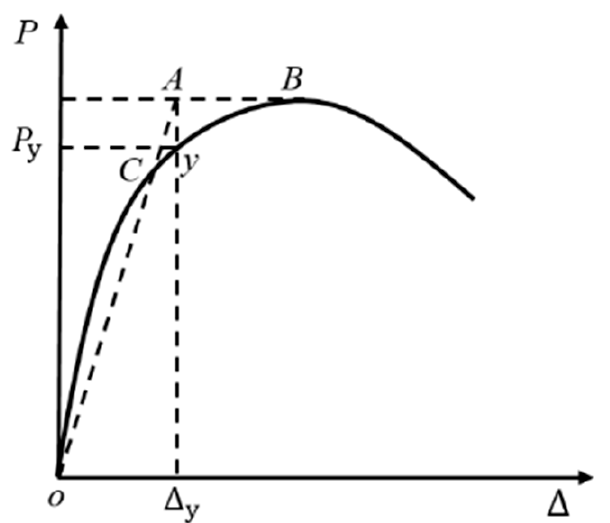
Figure 13. The method to determine yield point.